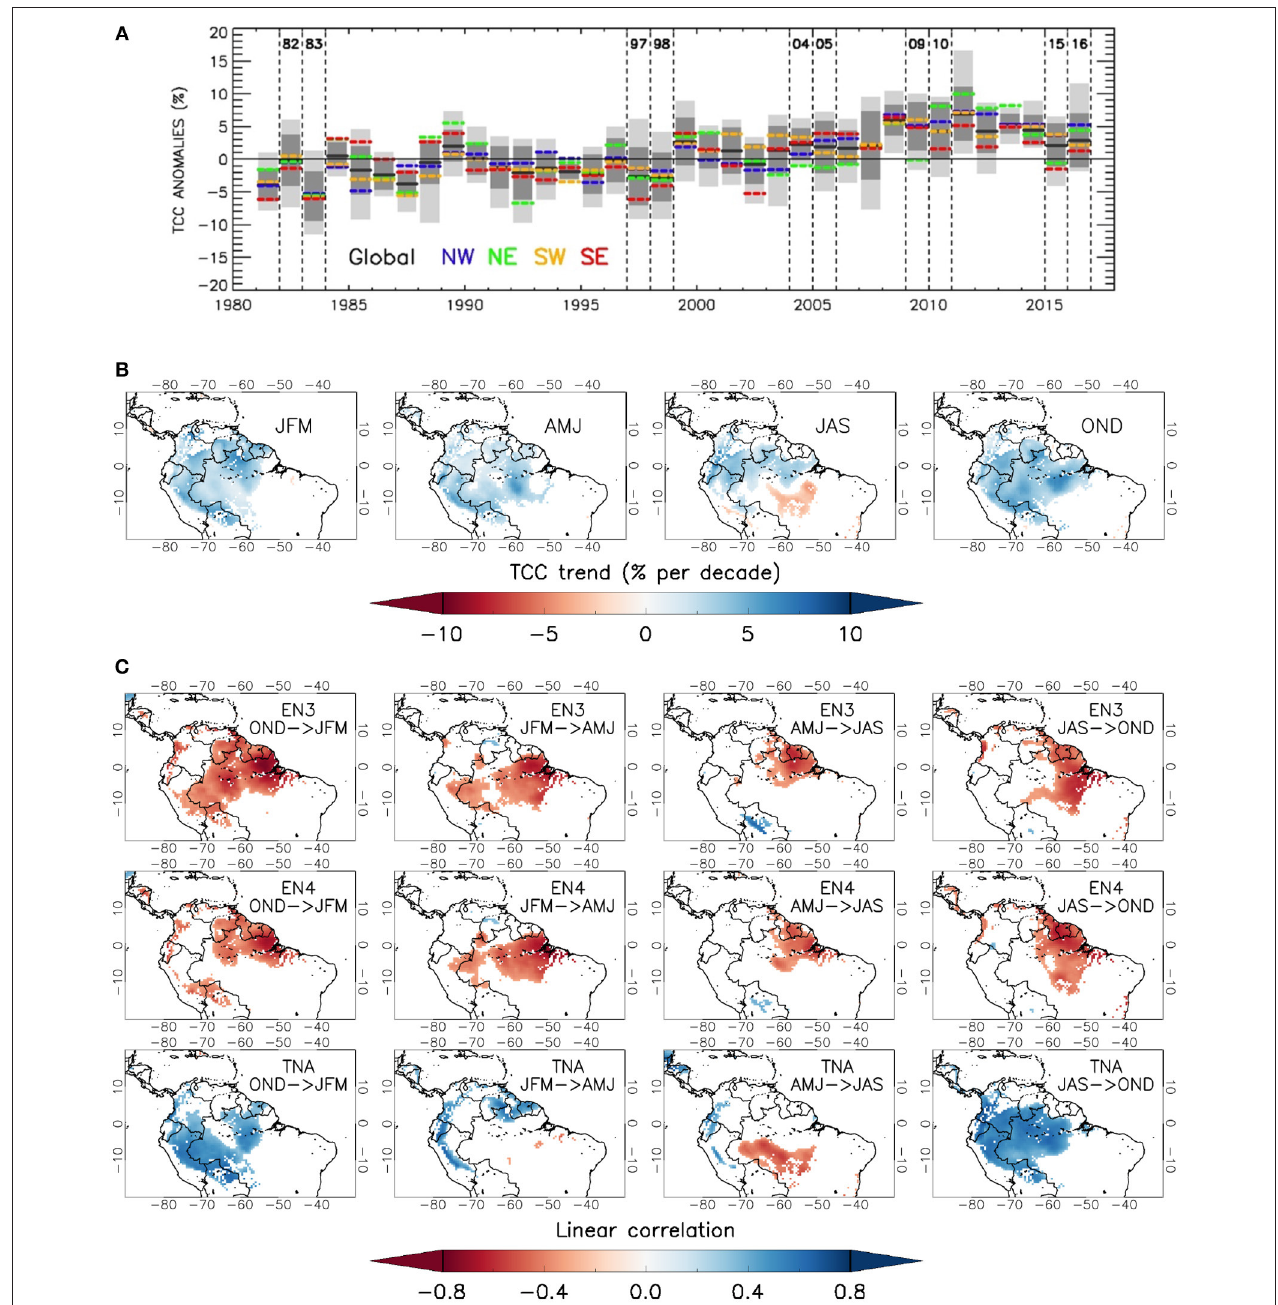
FIGURE 2 | (A) Temporal series of total cloud cover yearly anomalies over Amazonia for the period 1980-2016 over the four regions (NW, NE, SW, SE). Yearly anomalies for the whole Amazon Basin (Global) are included as gray boxes. Black line indicates the mean value, dark gray the ± 1 σ interval, and light gray the total range (maximum and minimum values). (B) Spatial patterns of trends (in percentage per decade) in total cloud cover over Amazonia for the four seasons JFM, AMJ, JAS, and OND. Only pixels with a statistical significance p < 0.05 are displayed. (C) Linear correlation coefficient between sea surface temperature anomalies over El Niño regions 3 and 4 (EN3, EN4) and Tropical North Atlantic (TNA), and total cloud cover anomalies. Only pixels with p < 0.05 are displayed. Correlation analysis was applied to seasonal SST and TCC anomalies with a lag of one season (SST anomalies for one particular season and TCC anomalies for the next season).